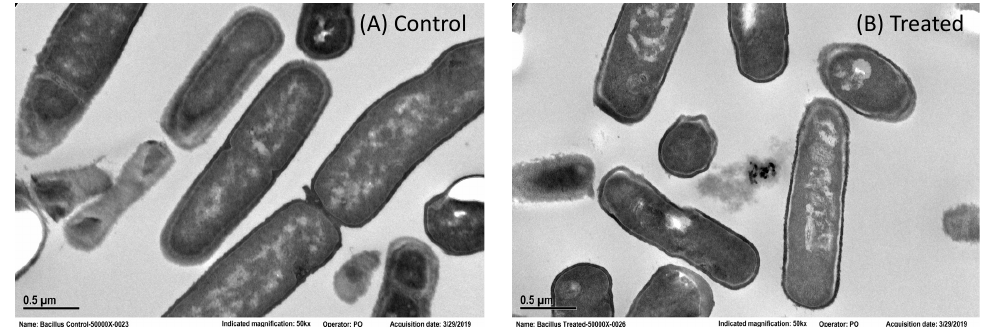
Figure 6. Representative TEM images of B. subtilis cells: ( A ) untreated, and ( B ) after treated with 0.1 mg/mL PEI&PEG-C/TiO 2 -Dots with visible light for 2 h.